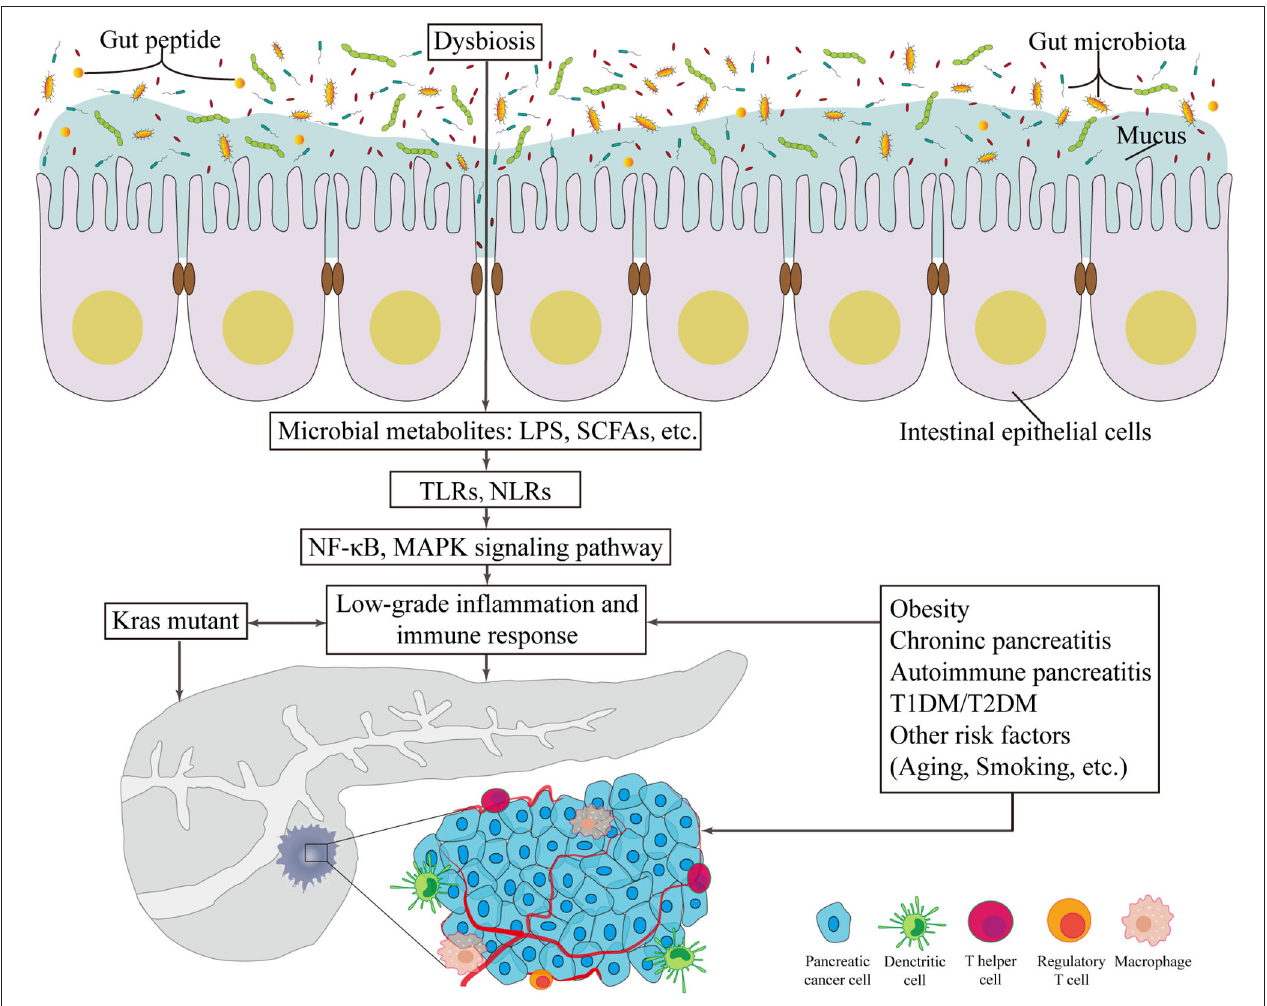
FIGURE 1 | The potentially carcinogenetic roles of gut microbiota in pancreatic cancer. Disorders of gut microbiota contribute to multiple changes associated with pancreatic cancer. Locally, it lowers the thickness of intestinal mucus and the level of gut peptide. Infiltrated bacterial metabolites, such as LPS and SCFAs, can render low-grade inflammation and immune responses via TLR and NLR that activates NF- κ B and MAPK signaling pathways. Besides, risk factors of pancreatic cancer provide novel consequential directions to explore the relationship between gut microbiota and pancreatic cancer. LPS, lipopolysaccharides; SCFA, short chain fatty acid; TLR, Toll-like receptor; NLR, Nod-like receptor; NF- κ B, nuclear factor kappa B; MAPK, mitogen activated protein kinase; T1DM, type 1 diabetes mellitus; T2DM, type 2 diabetes